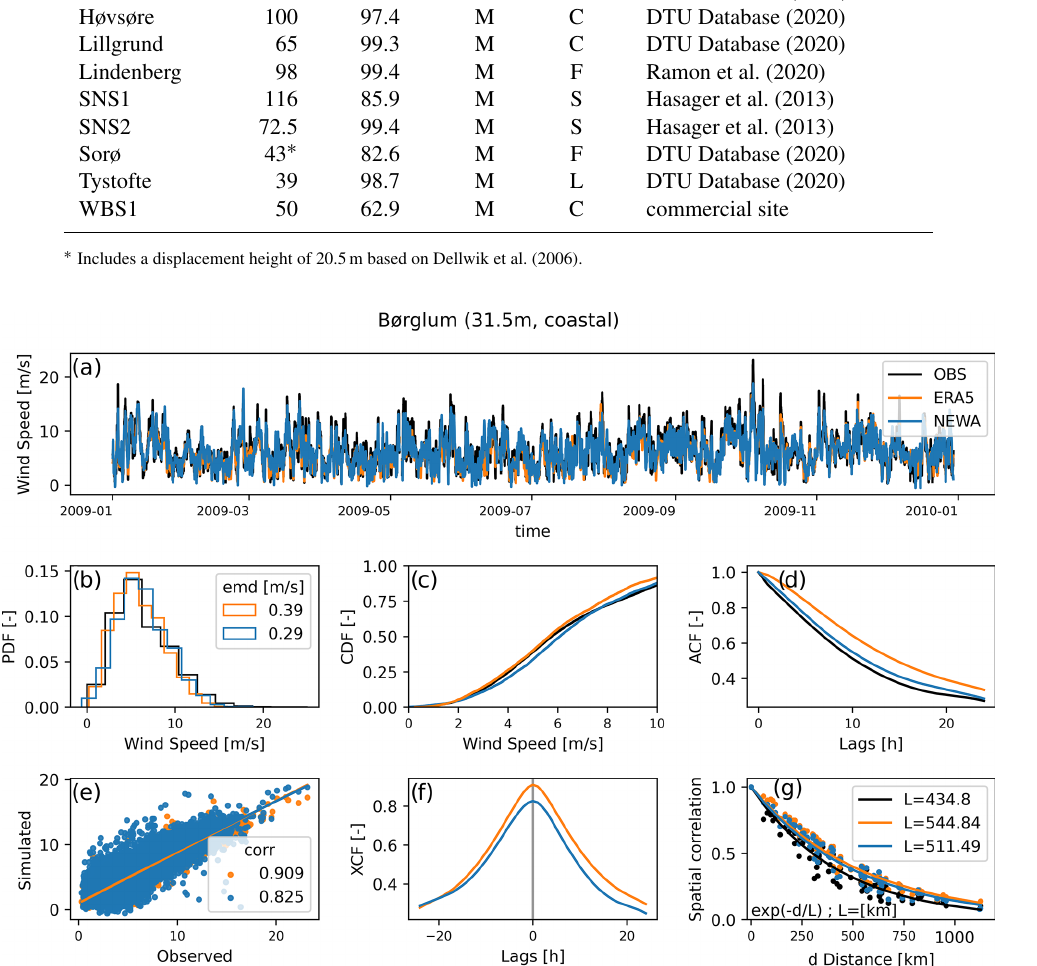
Figure 2. Example of the analysis done for one location (a–f) and all locations (g) comparing only observed data and two reanalyses (for simplicity) during 1 year. (a) Wind speed time series; (b) probability density function (PDF) and Earth mover’s distance (EMD); (c) cumulative density function (CDF); (d) autocorrelation function (ACF); (e) observed versus simulated wind speed; (f) cross-correlation function; (g) spatial correlations versus distance for all pairs of locations (dots) and their fitted curve